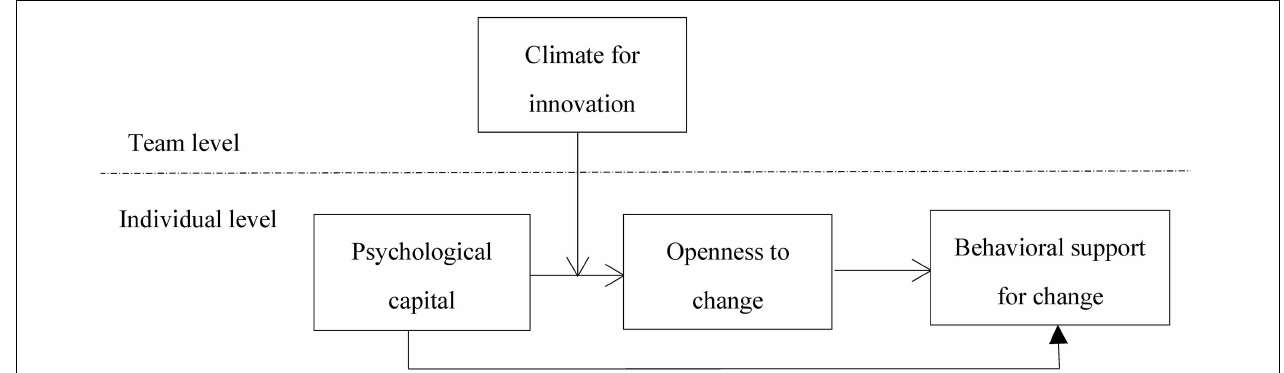
FIGURE 1 | The conceptual